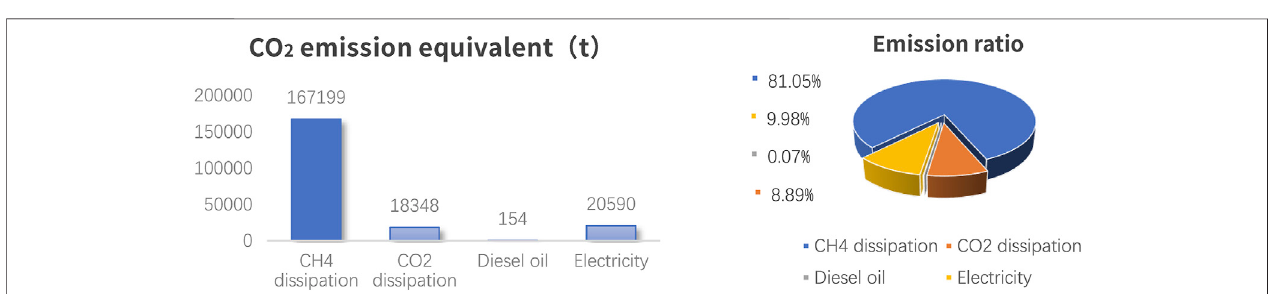
Frontiers in Energy Research |